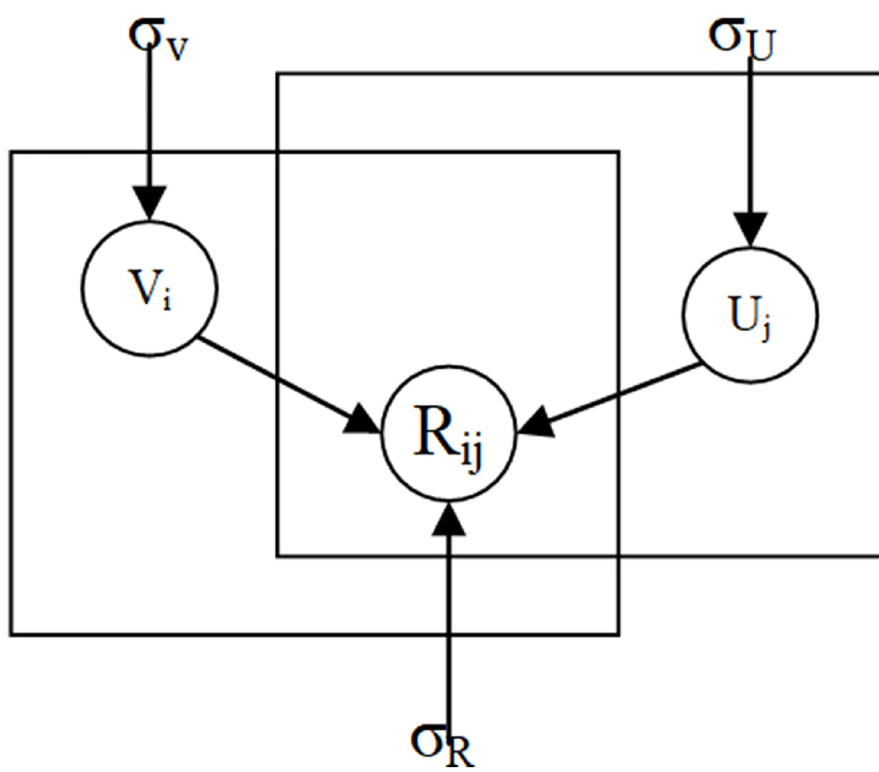
Fig 1. Probabilistic matrix factorization diagram